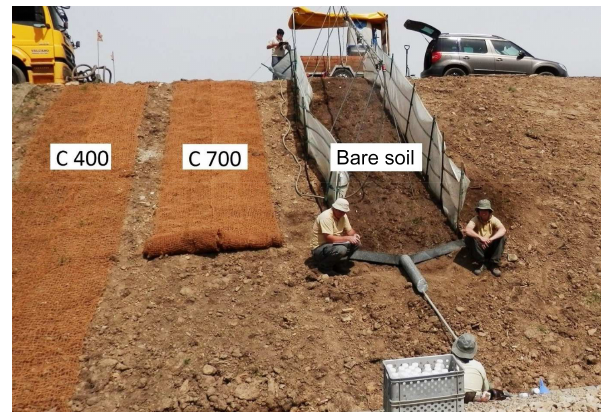
Figure 2. Experimental slope in the field (Rokycany, Czech Repub- lic). Rainfall simulation on bare soil (control sample) in progress. Note: the iron collecting trough at the bottom of the plot is hidden below the eroded material, as the image was taken during the rain- fall